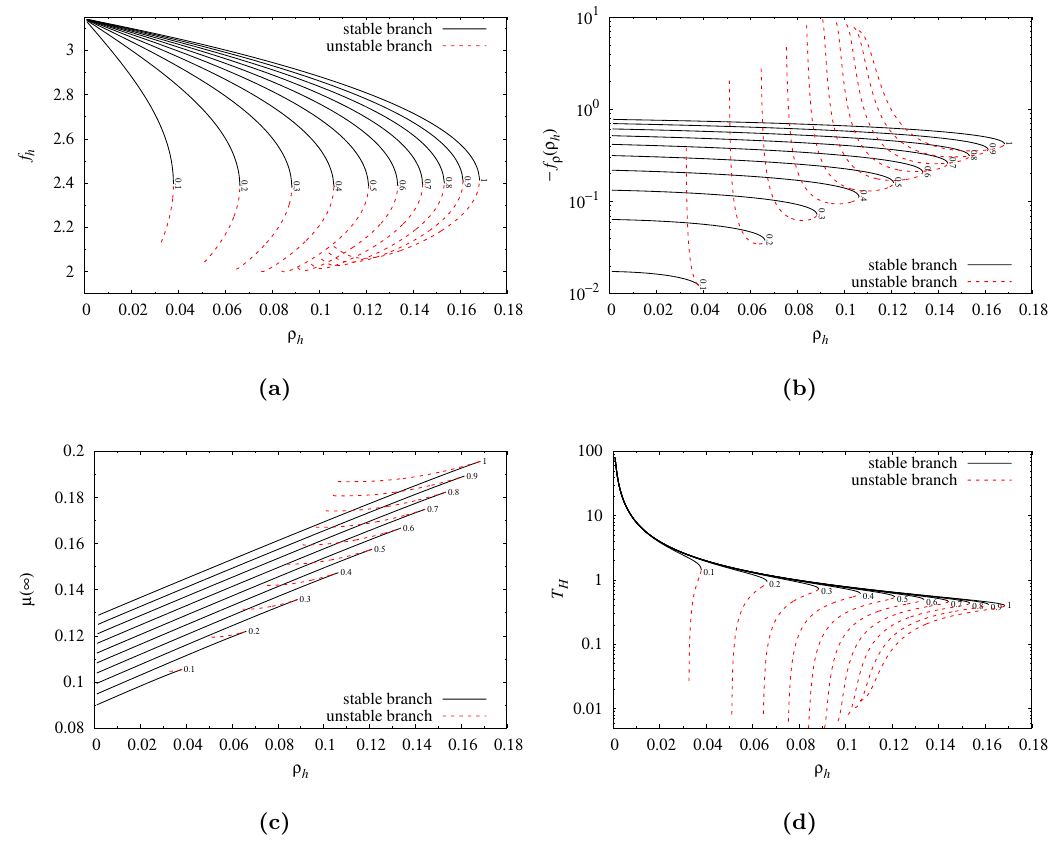
Figure 1 . Stable (black solid lines) and unstable (red dashed lines) branches of solutions in the 2 + 4 + 6 model: (a) the value of the pro(cid:12)le function at the horizon, f h ; (b) the derivative of the pro(cid:12)le function at the horizon, f (cid:26) ( (cid:26) h ); (c) the ADM mass, (cid:22) ( 1 ); (d) the Hawking temperature T H , all as functions of the size of the black hole, i.e. the horizon radius, (cid:26) h . The numbers on the (cid:12)gures indicate the di(cid:11)erent values of (cid:12) = 0 : 1 ; 0 : 2 ; : : : ; 1.